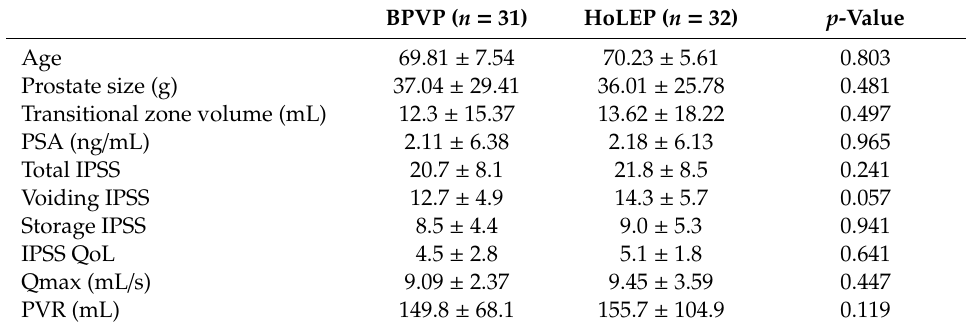
Table 1. Preoperative data of bipolar plasma vaporization of the prostate (BPVP) and holmium laser enucleation of the prostate (HoLEP)